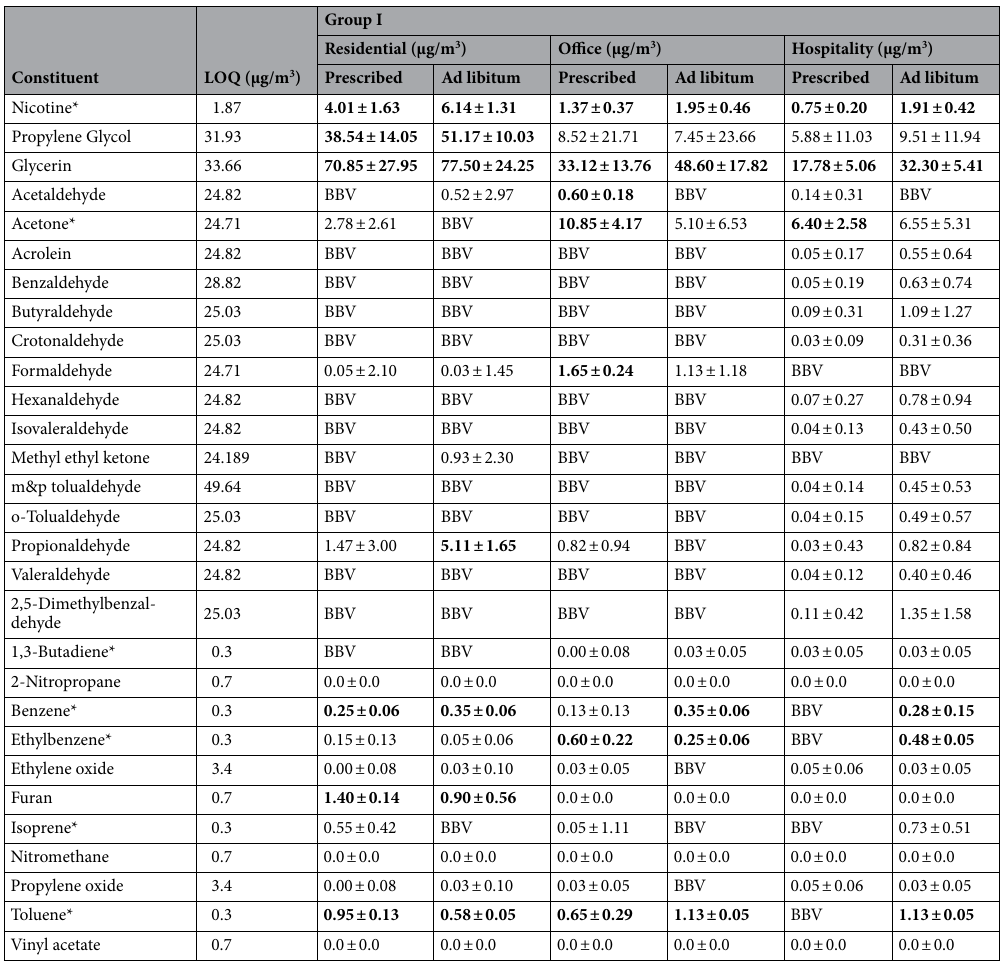
Table 3. Mean (± SD; N = 4) cumulative (4-h) constituent concentrations changes from baseline values for Group I for any constituent detected above LOQ for at least one puffing regimen for any group. Statistically significant constituent values from baseline (p < 0.05) are in bold. Statistically significant differences (p < 0.05) found in baseline concentrations (N = 4) between ventilation conditions are denoted with an asterisk. BBV Below baseline value, LOQ Limit of Quantification is based upon the amount of air sampled and is a composite average from all 4 air samplers used in the six